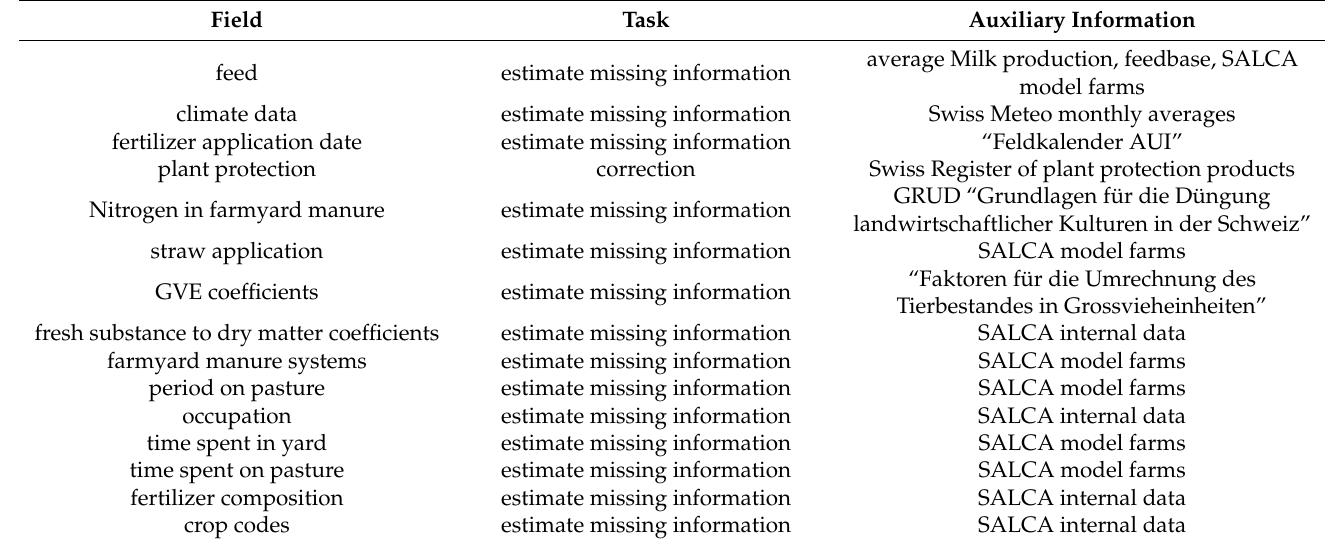
Table A1. Updated fields in production inventories.